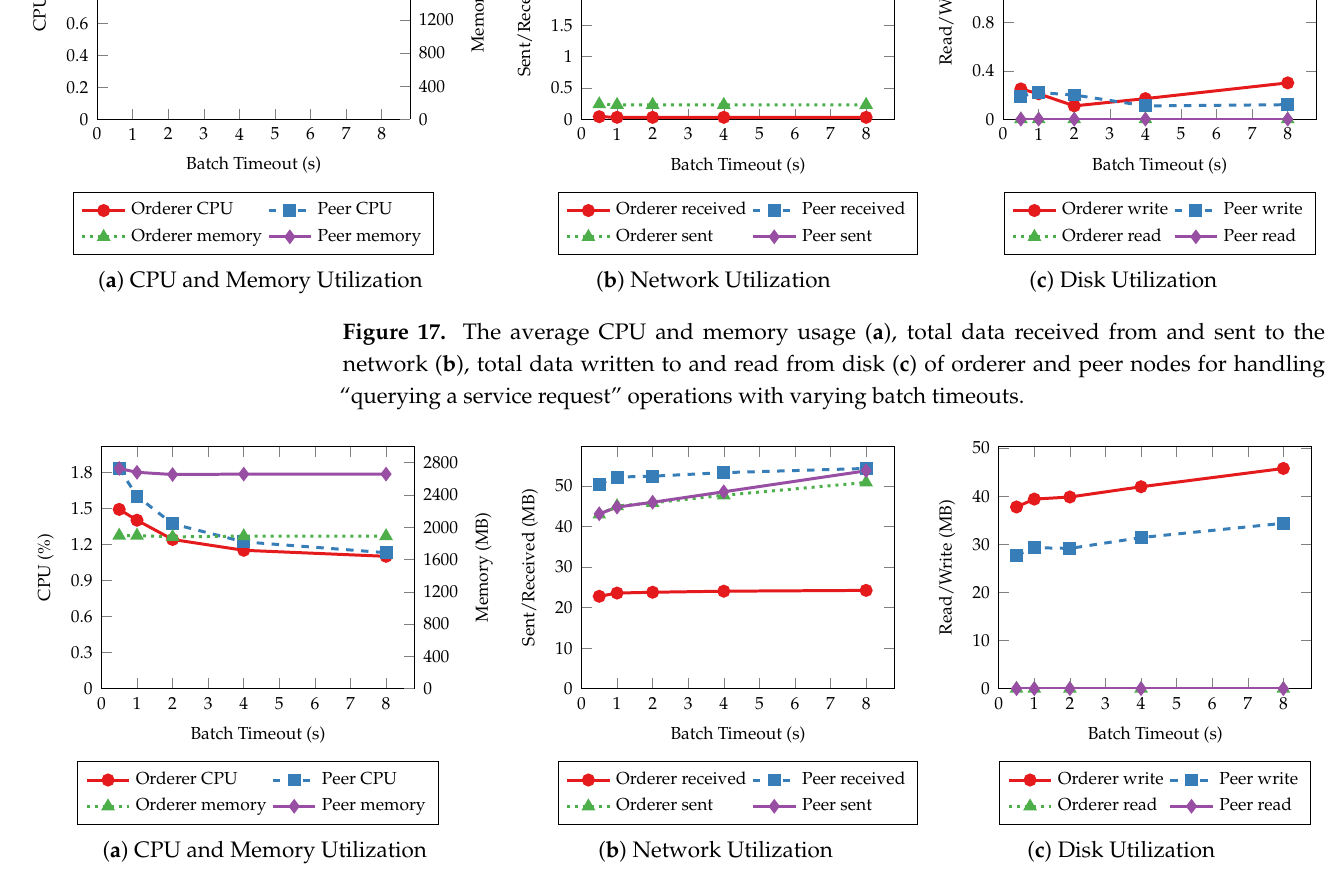
Figure 18. The average CPU and memory usage ( a ), total data received from and sent to the network ( b ), total data written to and read from disk ( c ) of orderer and peer nodes for handling “requesting for service” operations with varying batch